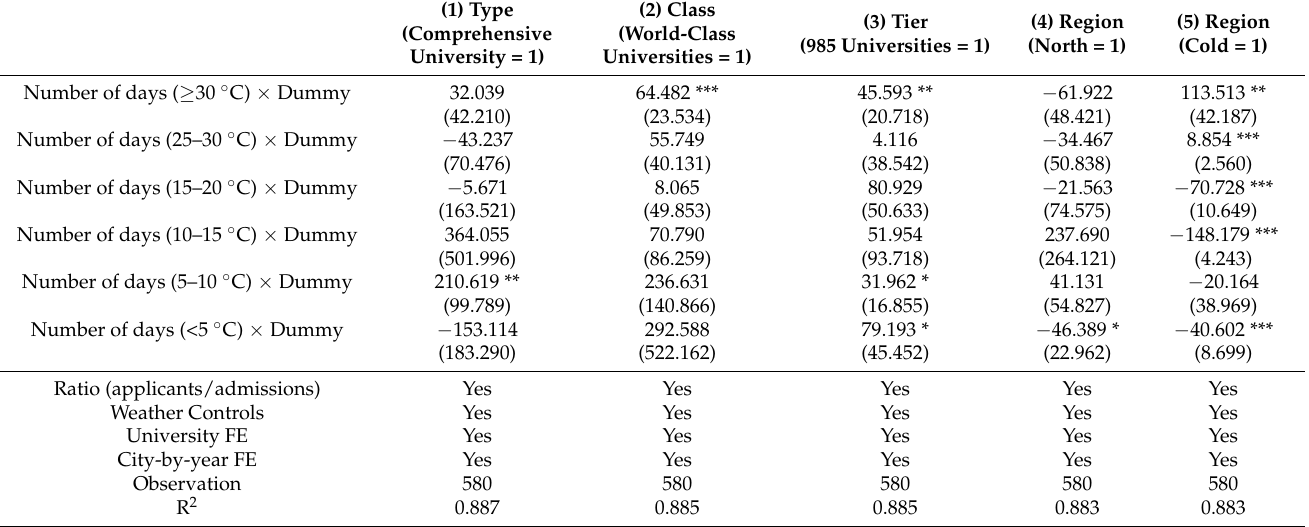
Table 9. Heterogeneous